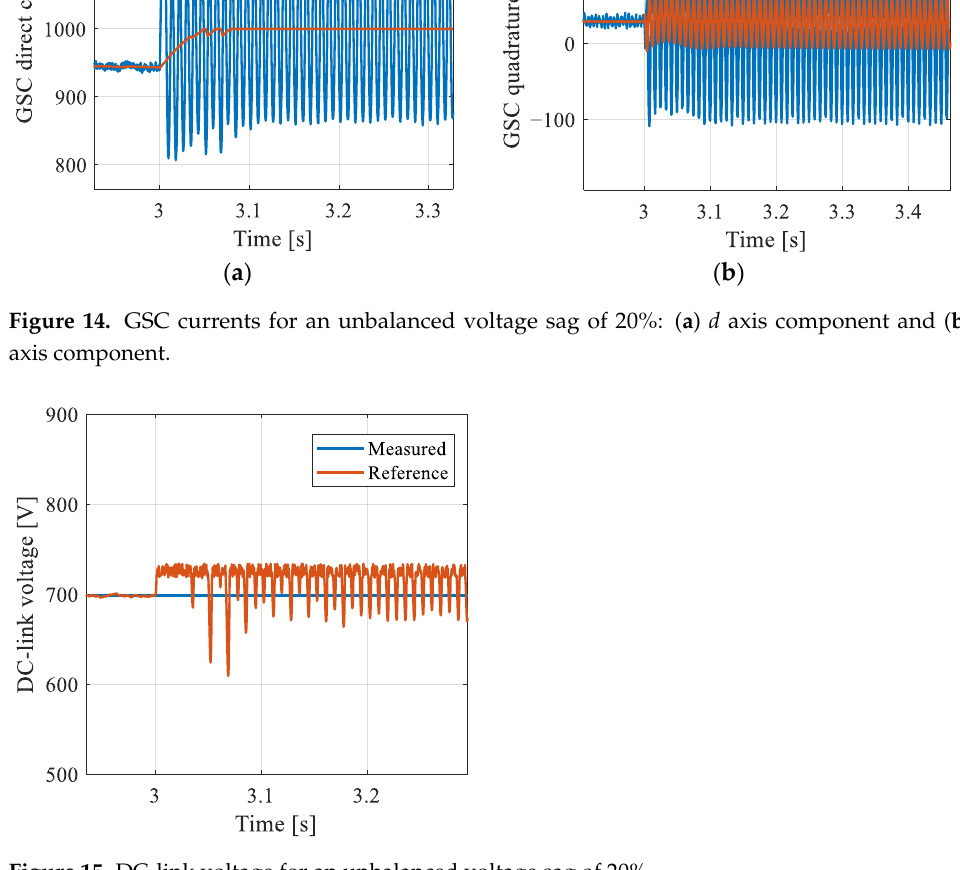
Figure 15. DC-link voltage for an unbalanced voltage sag of 20%.